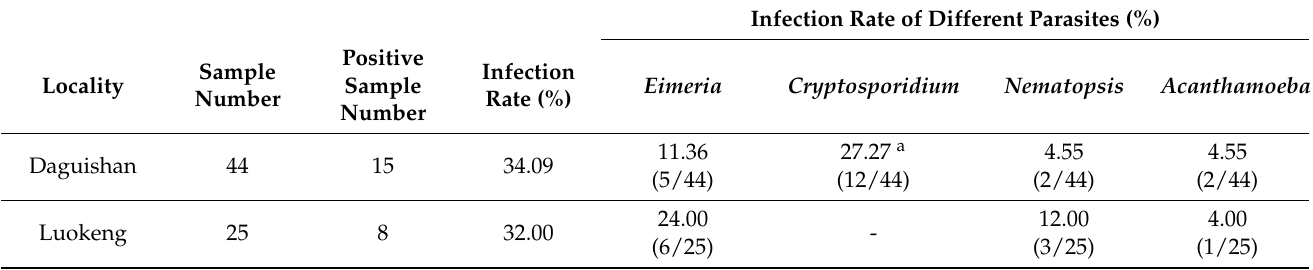
Table 3. Parasitic infection of crocodile lizards at different localities. Infection Rate of Different Parasites